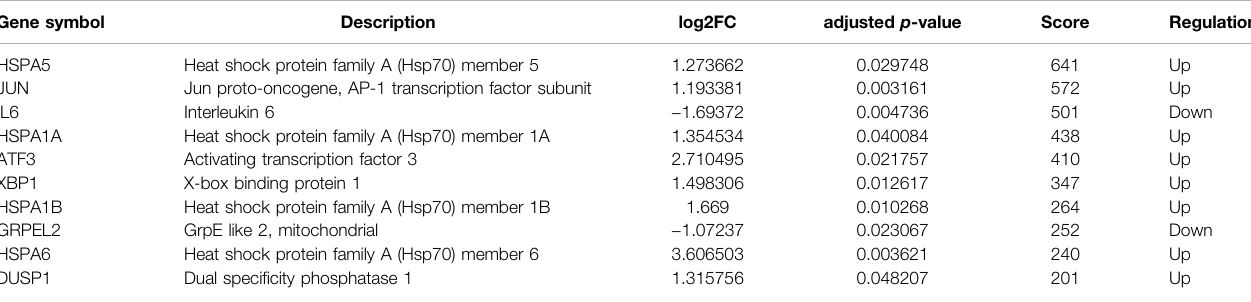
TABLE 2 | Top 10 hub genes ranked by MCC method in